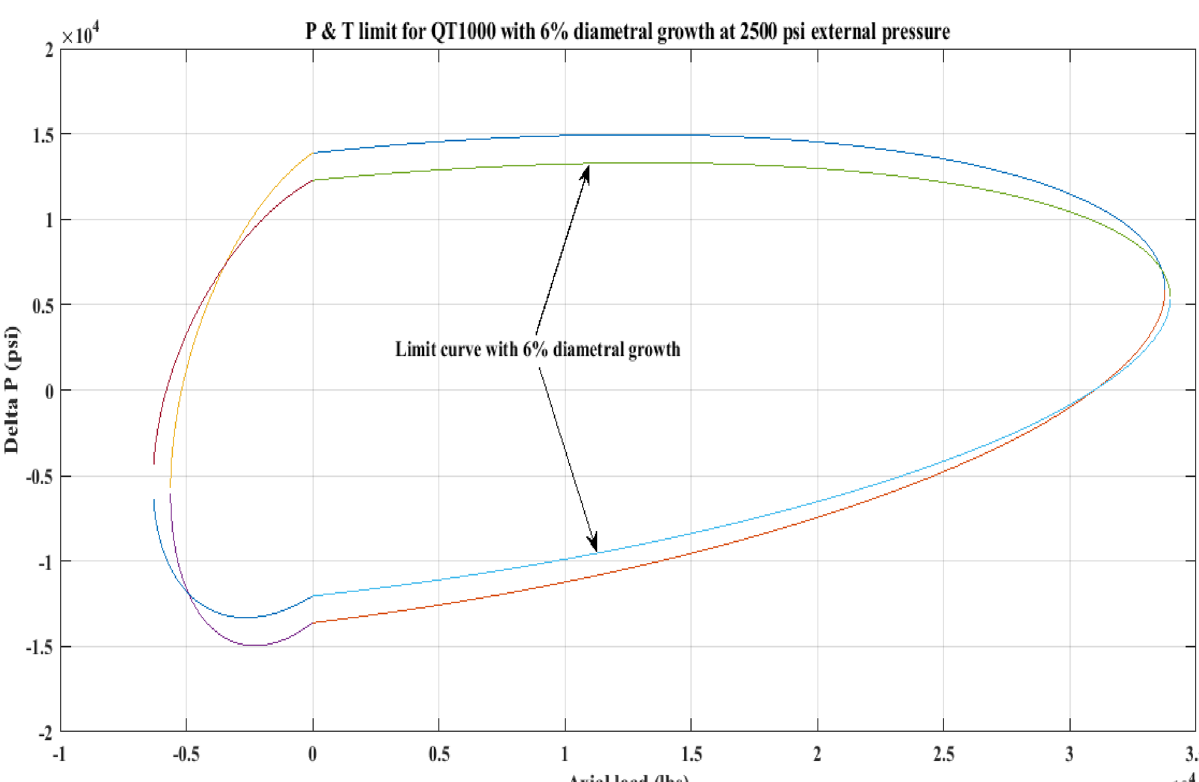
Figure 14. P and T limit with diameter growth for QT 1000 at 2500 psi P o